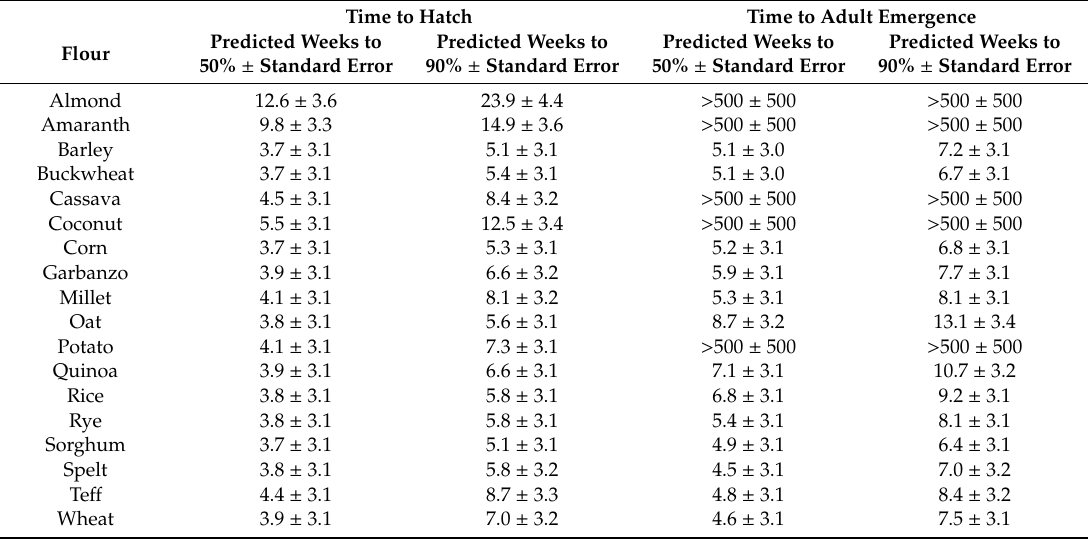
Table 6. Time to hatching and time to adult predicted 50% and 90% values for all flours tested. Table 50 and time to 90% values are inverse function adjusted and adjusted for time series. Hatch indicates any life stage other than